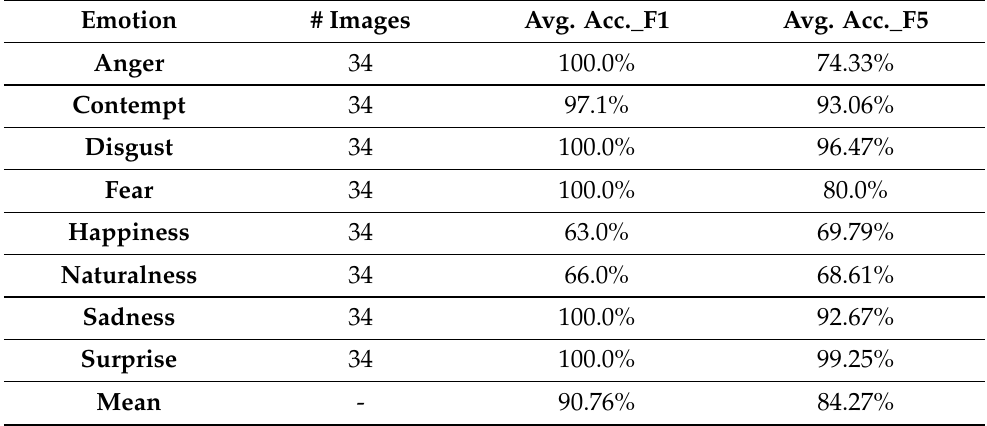
Table 1. Performance per class and average accuracy using both models, achieved with one-fold and five-fold cross validation, on test set from CK+